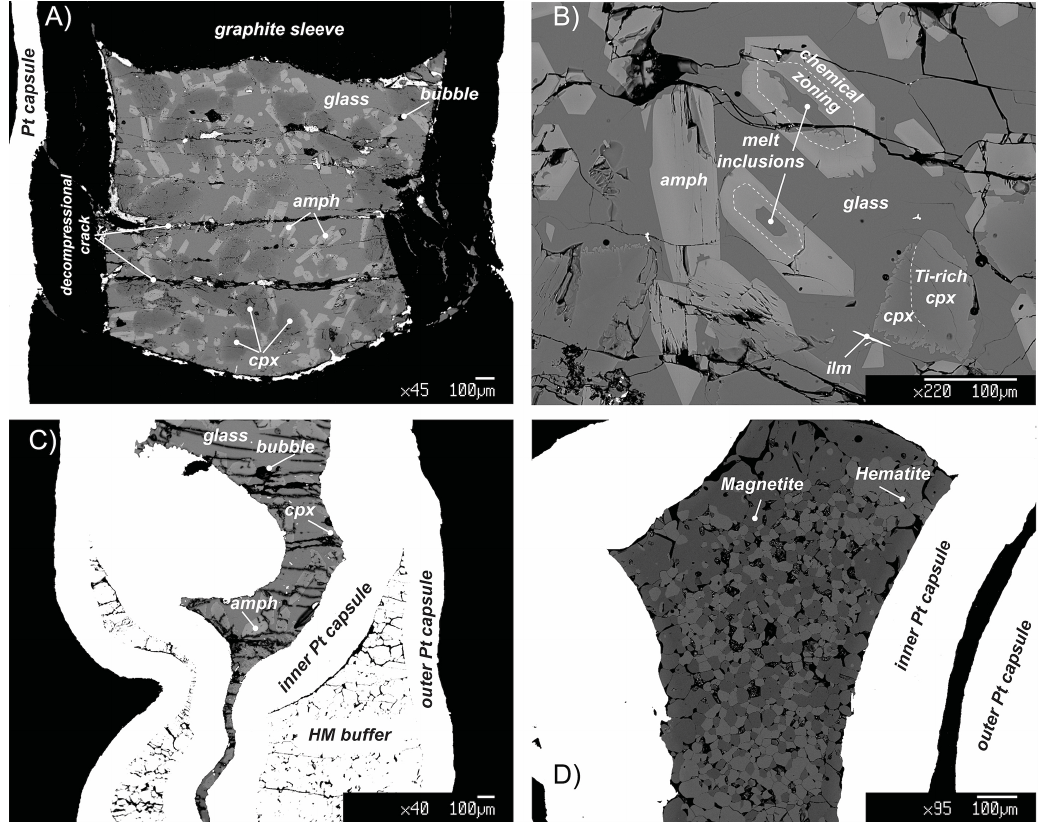
Figure 2. Representative back-scattered electron (BSE) images showing the representative textures in key experiments. (a) Panoramic view of the capsule of the run 17-9C: amphibole (amph) shows a rather polygonal habit and is crystallized from the residual melt (glass) reacting with the former clinopyroxene (cpx). (b) Texture of experiment 17-4C showing amphibole (amph) replacing clinopyroxene (cpx). Amphibole includes small pockets of glass that reacts with the amphibole creating light chemical zoning. During the cooling, clinopyroxene grains react with the surrounding melt as evidenced by the corroded grain boundaries (ilm: ilmenite). (c) BSE overview image of the run 18-15HM (double-capsule design). (d) BSE image of the hematite–magnetite (HM) buffer of the run 17-8HM (triple-capsule